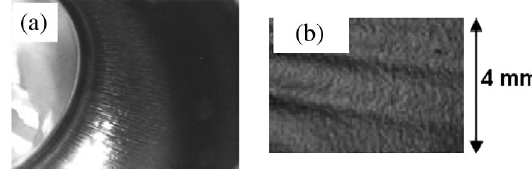
FIG. 17. (a) Bubble traces visible on the upper cell after EP at 20 V and (b) similar features obtained on samples electropol- ished vertically at similar voltage [10].